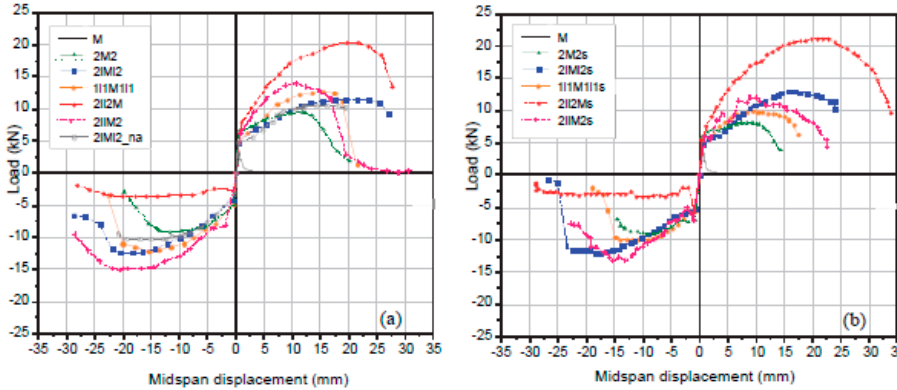
Figure 4. Envelope curves for out-of-plane loading: ( a ) 2 mm displacement increment; ( b ) 1 mm displacement increment.